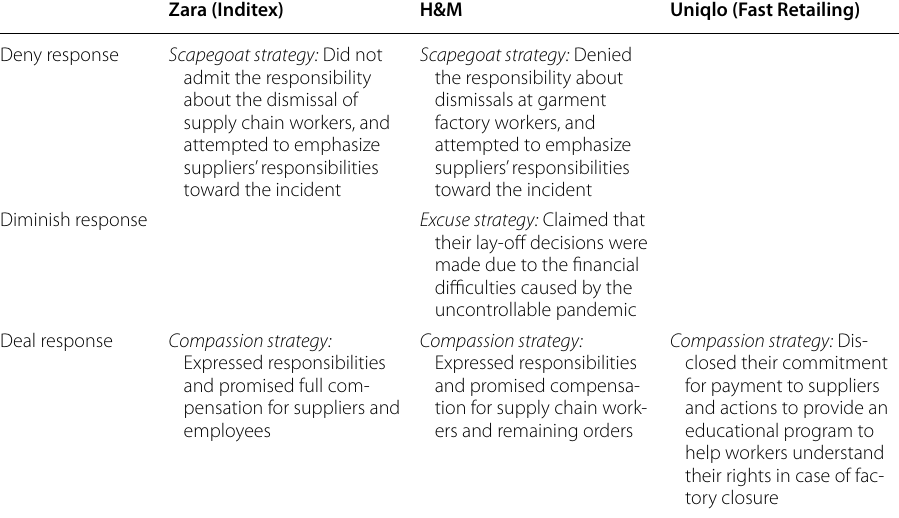
Table 6 Comparison of the retailers’ crisis response strategies toward internal issues during the COVID-19